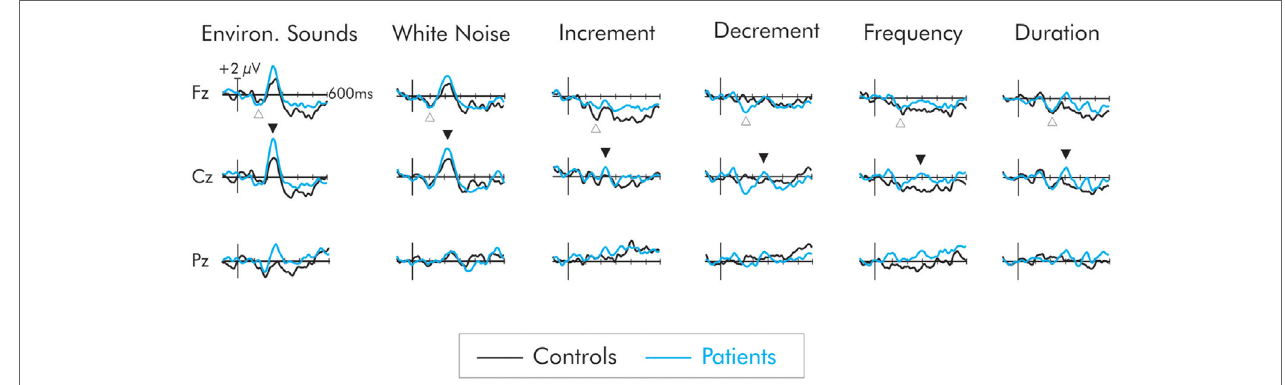
FigUre 3 | Difference waves for the six deviant stimuli for patients (blue) and controls (black). The deviant-related negativity (DRN) is indicated by an open upward arrow and the P3a by a closed downward arrow. All deviants elicited a DRN but in general, its amplitude did not differ between groups. Only the environmental sounds and white noise elicited a large P3a. The P3a for these deviants was larger in amplitude for the patient group. The deviants representing a smaller extent of change did not elicit a P3a in the control group. A small P3a was however elicited in the patients but its amplitude did not significantly differ from that of the